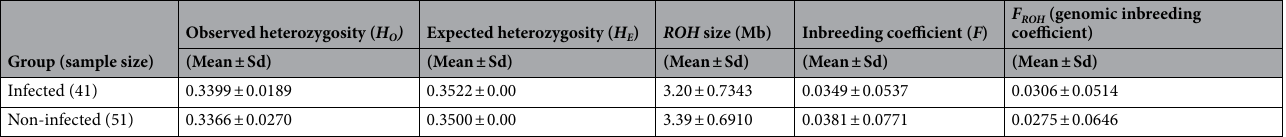
Table 1. Estimates of genetic diversity parameters for the infected and non-infected cohorts of Tunisian sheep.